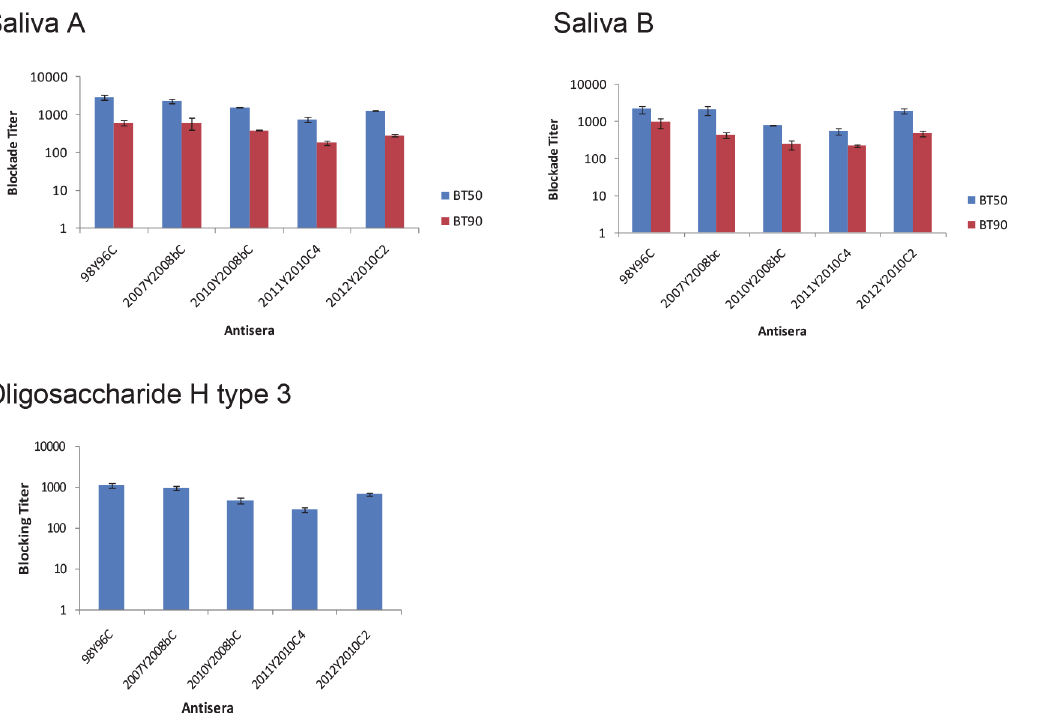
Fig 5. The antibodies from mice immunized with P particles from the 2008b and 2010 clusters blocked GII.4 P particle (VA387, 98Y96C) binding to A-, B-type saliva, and H type 3 oligosaccharide. VA387 P particles were blocked with mouse antisera against each of the five strains (2007Y2008bC, 2010Y2008bC, 2011Y2010C4, 2012Y2010C2, and 98Y96C). The y-axis indicates the serum dilution (blockade titer) as determined from optical density values. The blue bars indicate the antiserum titer at which 50% of the binding was blocked (BT 50 ) compared to unblocked controls and red bars indicate the titer at which 90% of the binding was blocked (BT 90 ). The results are averaged from at least two independent